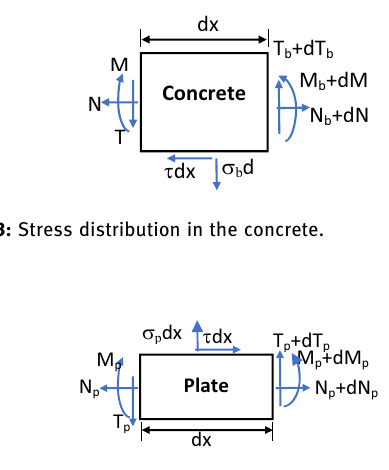
Figure 4: Stress distribution in the composite material plate.